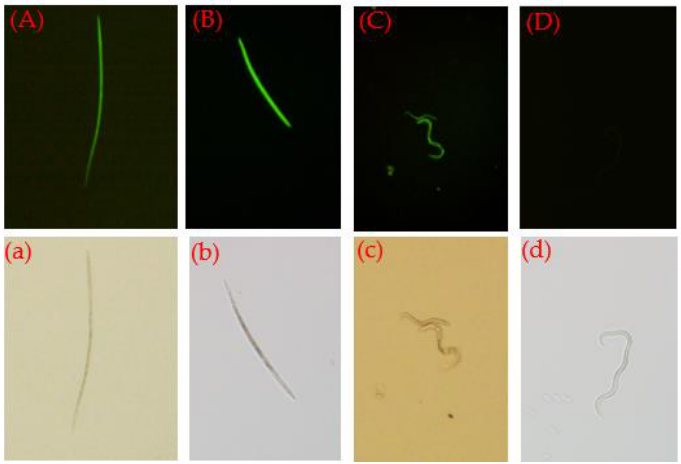
Figure 8. Reactive oxygen fluorescence staining of B. xylophilus . B. xylophilus was imaged in the darkfield ( A – D ) and the corresponding brightfield ( a – d ). The a – d groups were treated with 0.2 mM 2-coumaranone, 0.2 mM cyclo-(Phe-Pro), reactive oxygen hydrogen donor, and 5% DMSO, respec- tively.